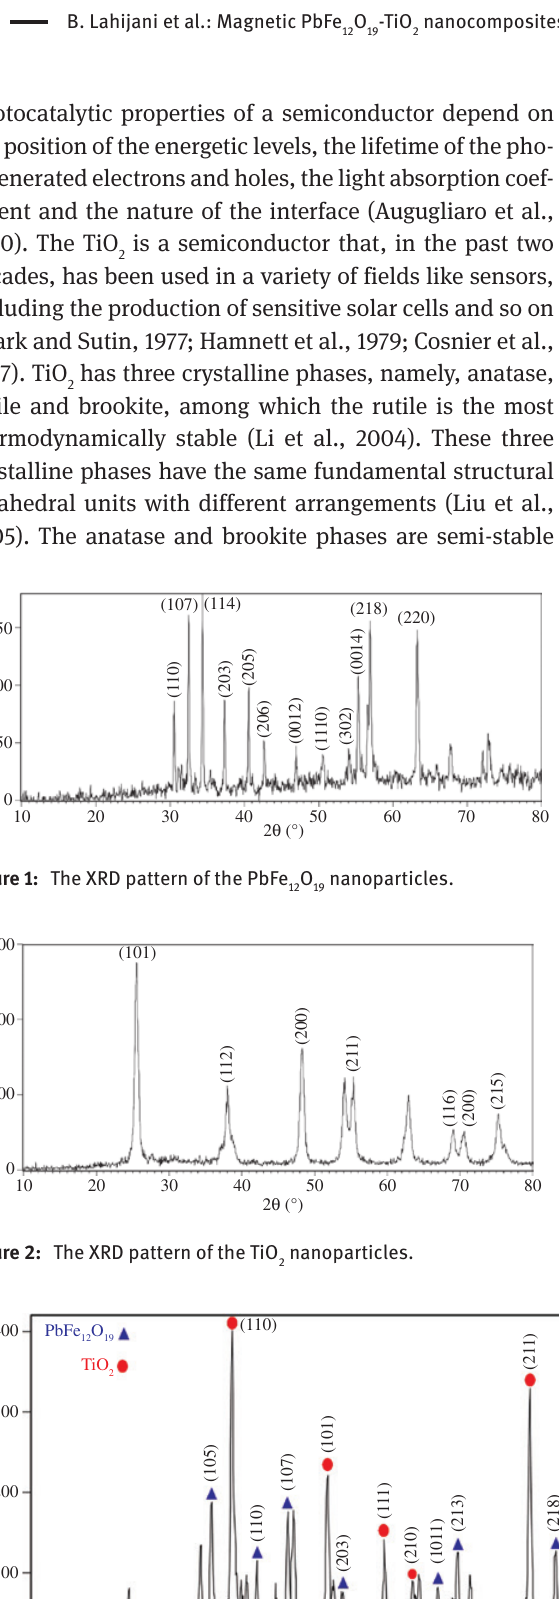
O -TiO nanocomposites. 12 19 2